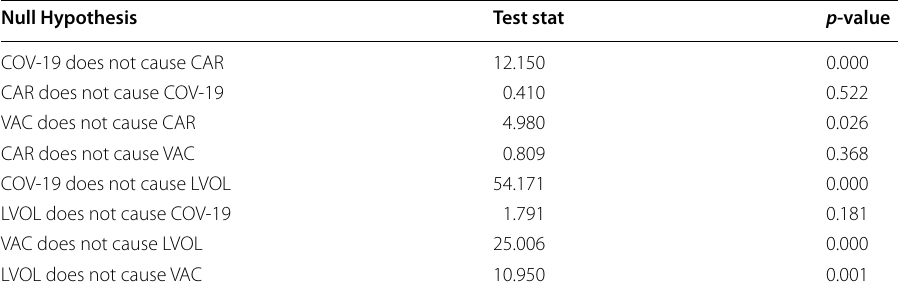
Table 7 Panel granger causality test